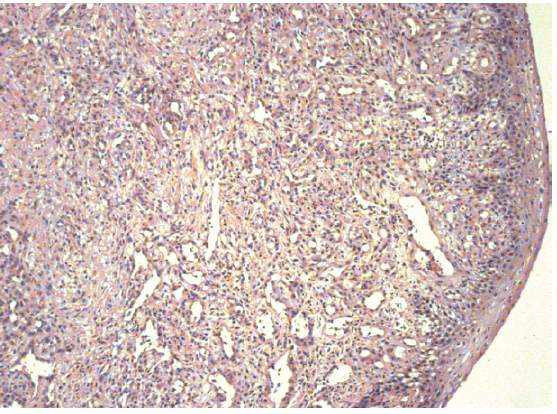
Figure 4. Histopathological findings revealed a mixed cavernous and capillary hemangioma (HE